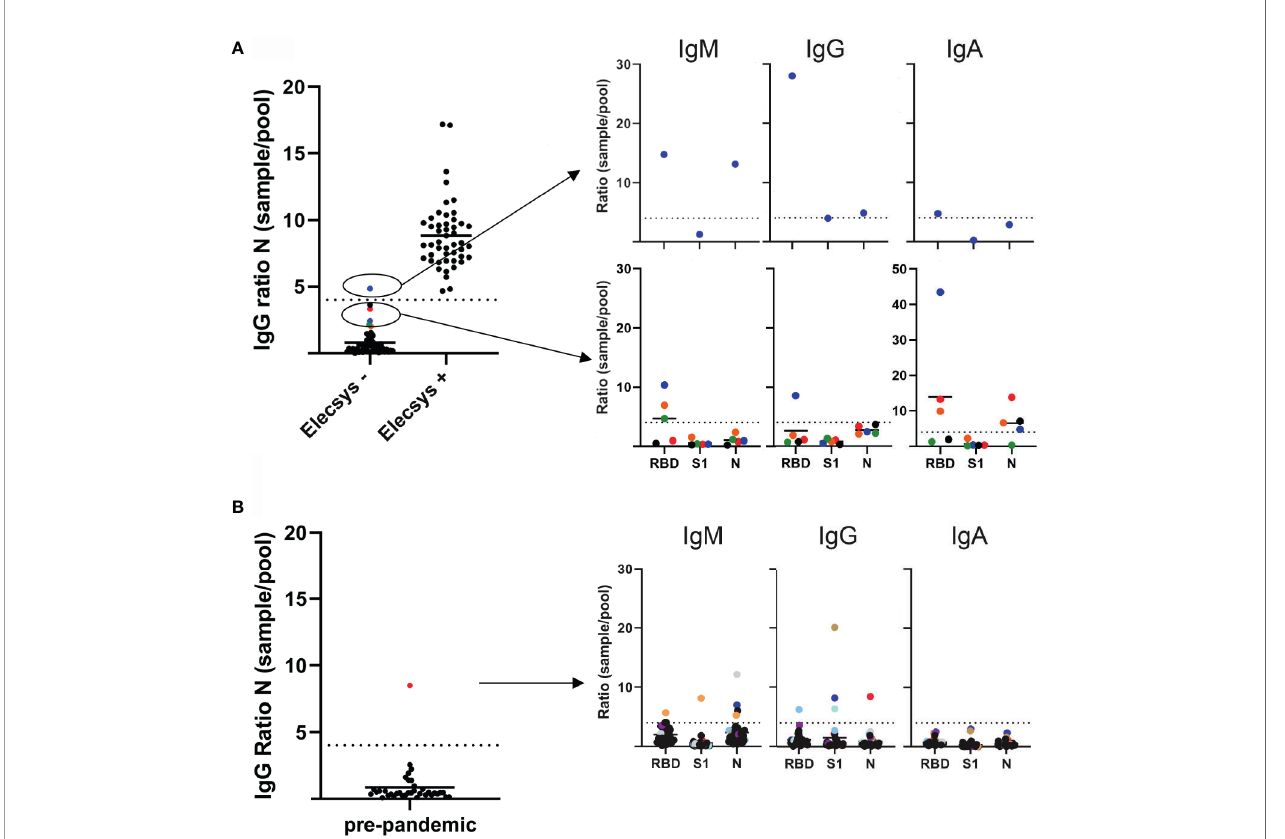
FIGURE 1 | SARS-CoV-2 antibody levels as measured by a multiplex based assay and calibrated against the Elecsys ® Anti-SARS-CoV-2 assay (Roche diagnostics). (A) 100 serum samples previously analyzed by Elecsys ® assay (depicted on the x axis as negative and positive), were received from the Department of Clinical Microbiology, and SARS-CoV-2 IgG antibodies against the N protein were analyzed blindly by multiplex (left panel). Right top panel depicts the single sample that had a SARS-CoV-2 IgG >4 sample/pool ratio for the N protein. Bottom right panel depicts the samples that showed a >2 but <4 than 4 sample/pool ratio by multiplex. (B) Left panel depicts 36 serum samples received in 2019 by the Department of Immunology. SARS-CoV-2 IgG antibodies against the N protein were analyzed by multiplex. Right panel depicts the serum/pool ratio of the serum samples against RBD, S1 and N proteins. Samples above the cut-off level are color